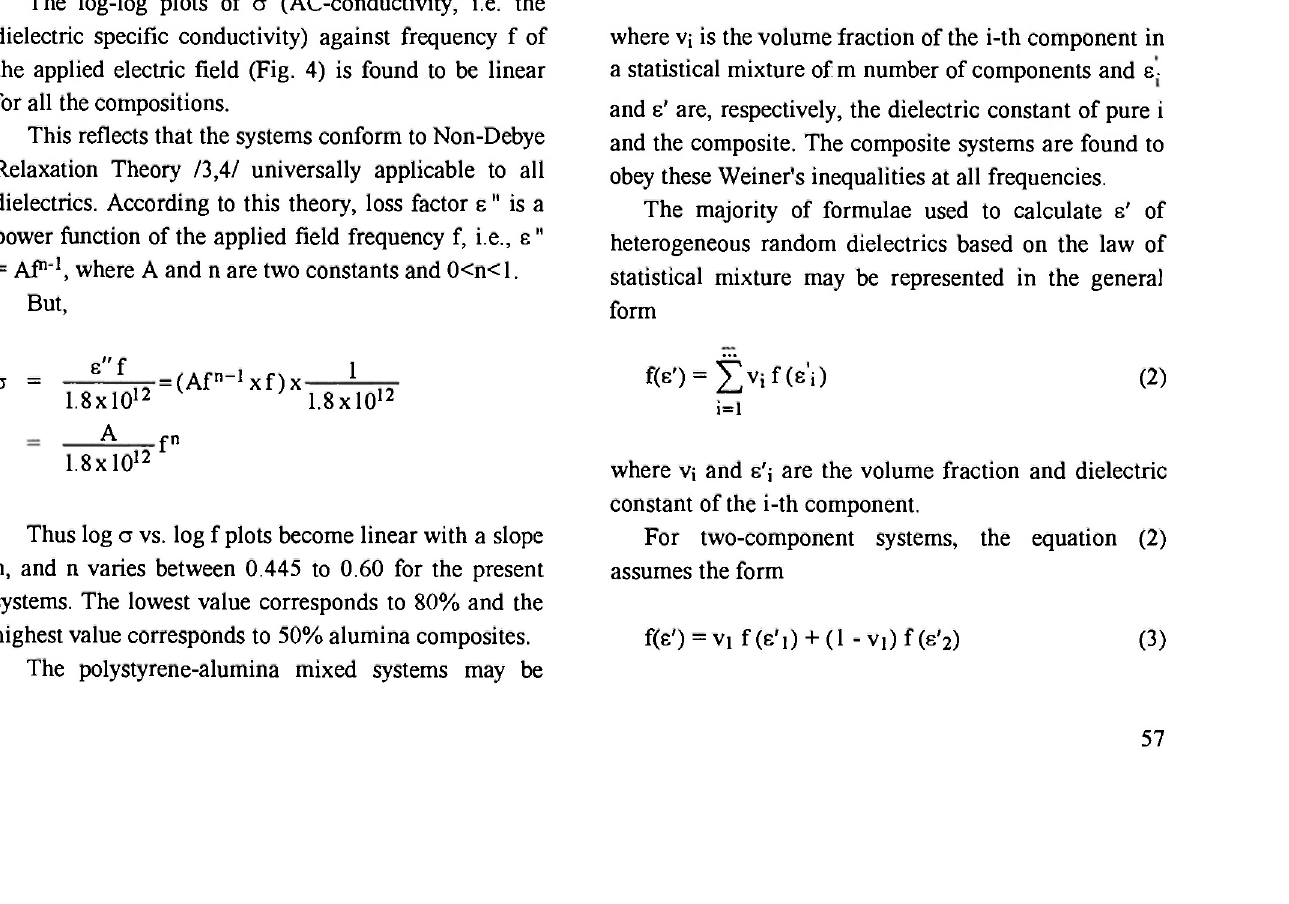
Fig. 3: Plots of relative dispersion Δε'/ε κ and rela- tive relaxation of Δε"/ε" against weight frac- tion of